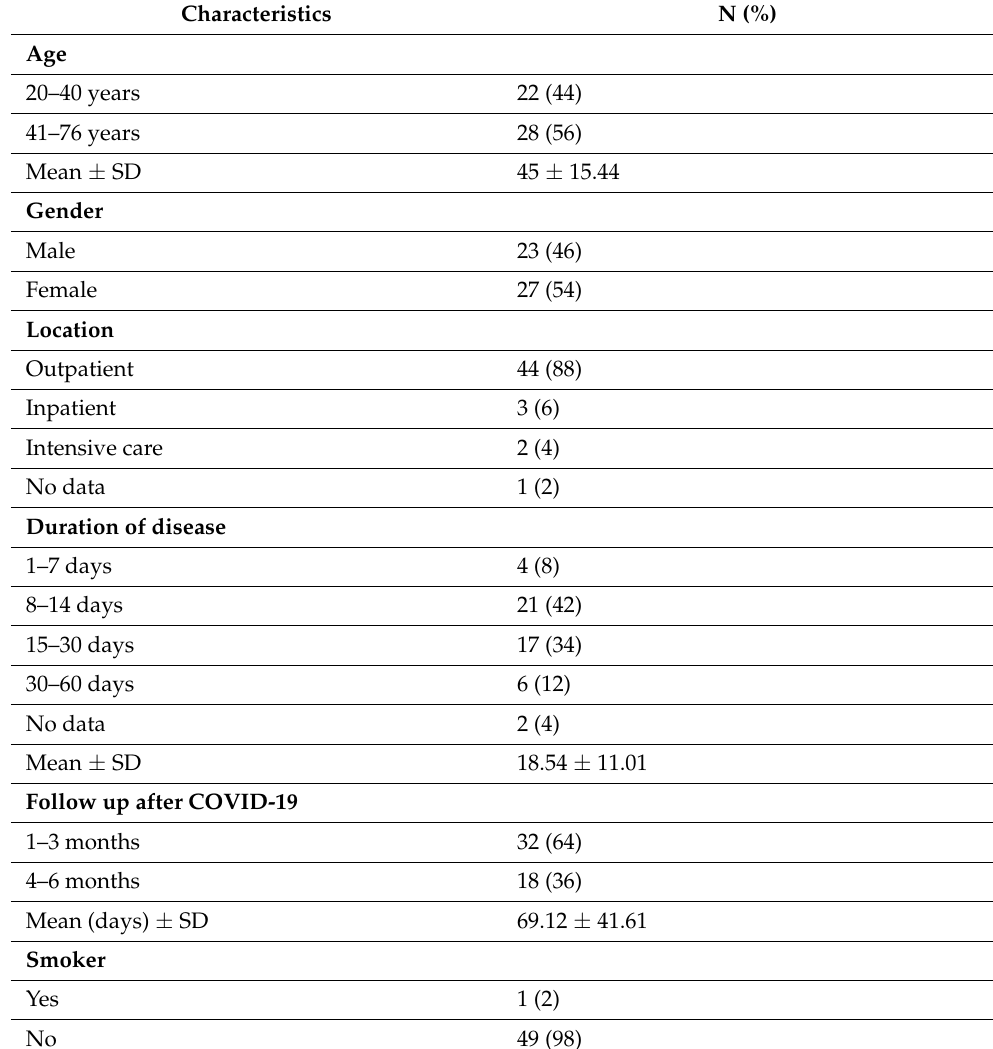
Table 1. Characteristics of COVID 19